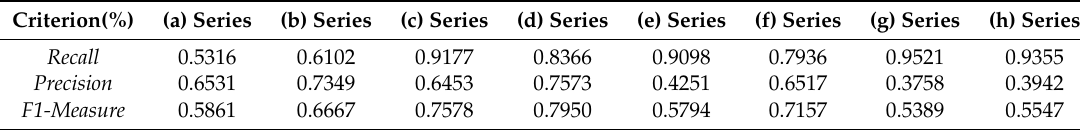
Table 1. Quantitative pixel-level defect detection results for the proposed MSCDAE model on samples from (a) to (h) series (each series contains 20 images with real defects).